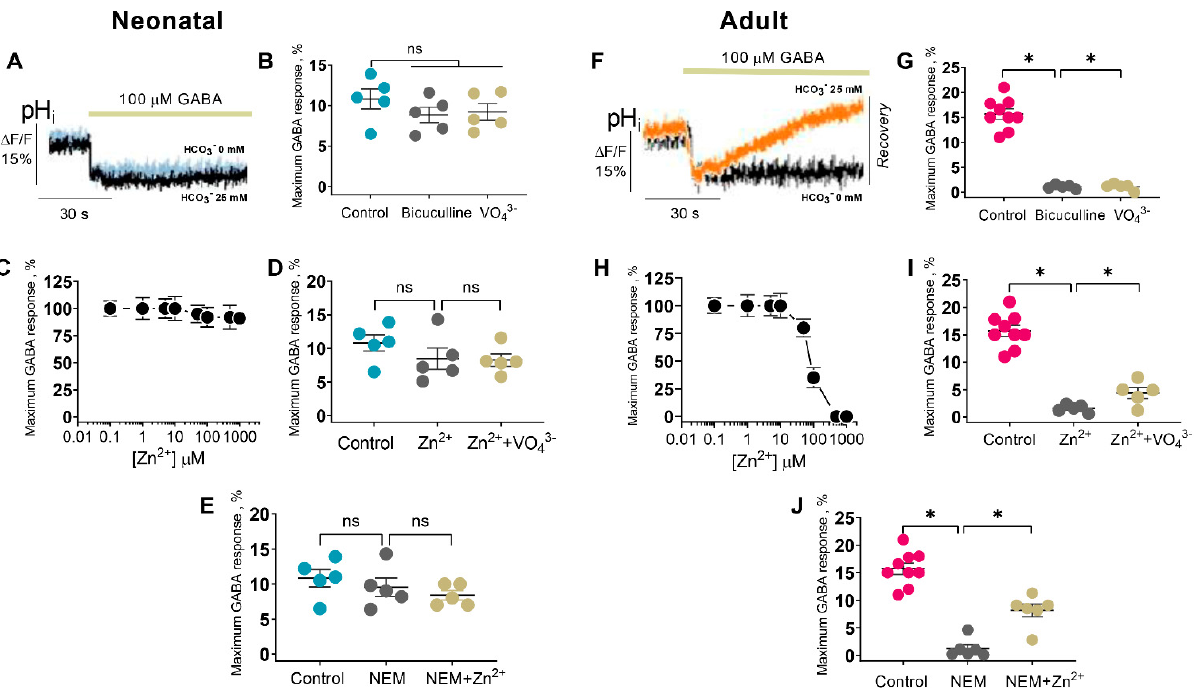
Figure 3. Zinc inhibits the GABA A R-mediated [HCO 3 − ] i recovery in mature neurons. ( A , F ) Cor- responding BCECF fluorescence changes for SNs (P1) and (P35) recording in response to 100 µ M GABA application without or with 25 mM HCO 3 − in an experimental medium, respectively. ( B ) Bar chart showing average maximum GABA response before and after 40 µ M bicuculline or 25 µ M VO 43 − application: Student’s unpaired t -test, p = 0.2433 ( n = 5) and p = 0.3434 ( n = 5). ( C , H ) Zn 2+ concentration inhibition curve recording for average maximum the GABA response. ( D ) Bar chart showing average maximum GABA response before and after 300 µ M Zn 2+ or 300 µ M Zn 2+ + 25 µ M VO 43 − application: Student’s unpaired t -test, p = 0.2734 ( n = 5) and p = 0.8019 ( n = 5). ( E ) Bar chart showing average maximum GABA response before and after 300 µ M NEM or 300 µ M NEM + 300 µ